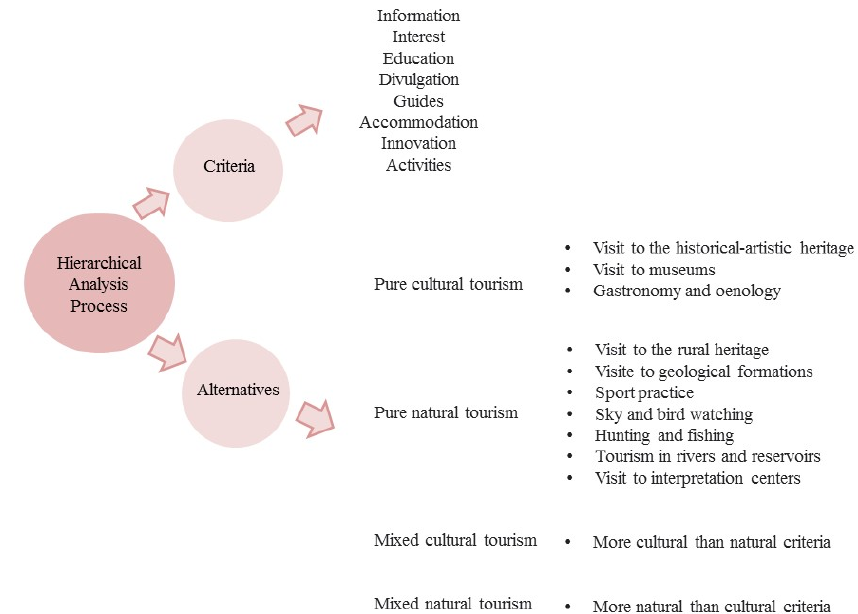
Figure 4. Synthesis of the hierarchical analysis process. Criteria and alternatives.